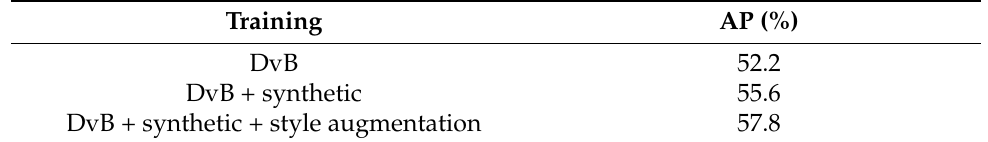
Table 2. Performance of different training strategies evaluated on images from an unknown sequence. The performance is reported when training only with images from the Drone vs. Bird (DvB) Challenge and when the synthetic dataset and style augmentation are